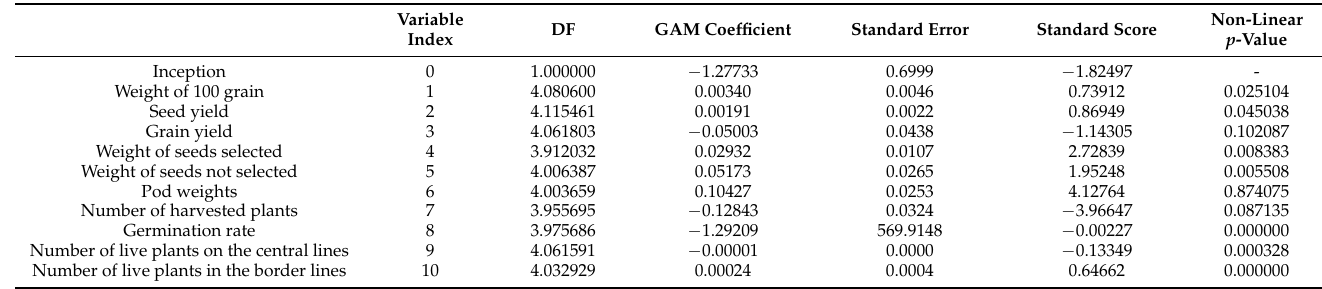
Table 5. Result of a generalized additive model for the most essential studied plant traits.